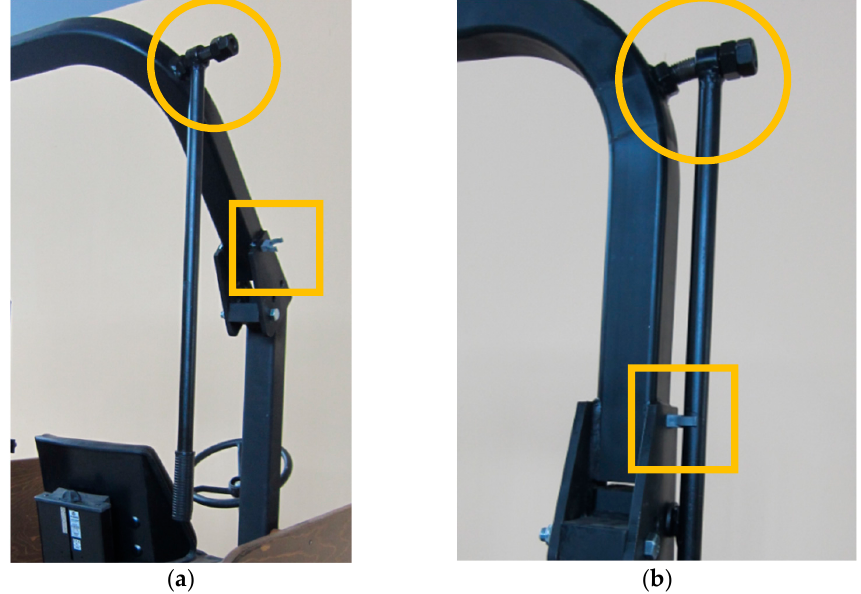
Figure 10. The rod proposed as a solution to increase FROPS reachability. In both figures ( a , b ), a coloured square highlights the fixing and connection joint of the rod with the FROPS, while a coloured circle highlights the retention mechanism to lock the rod when in rest position.